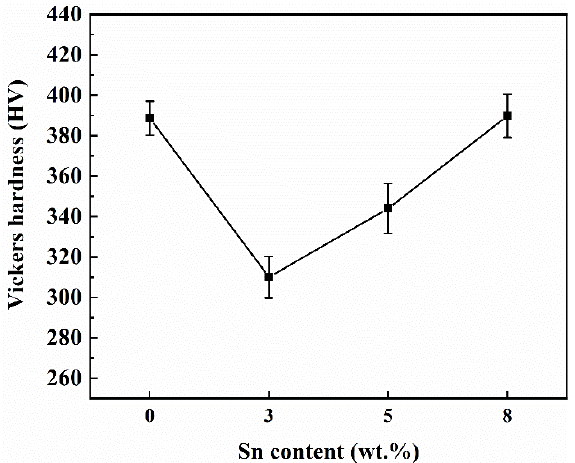
Figure 4. Vickers hardness of PM-fabricated Ti-10Nb-xSn alloys.